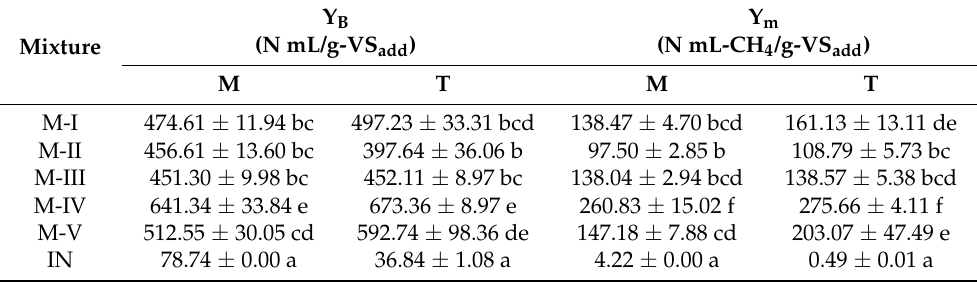
Table 3. Summary of the results of BMP assay plus One-Way ANOVA results with Tukey HSD test (values marked with the same letter in the graph are not significantly different to Tukey test, p > 0.05). Y B Y m (N mL/g-VS add ) (N mL-CH 4 /g-VS add ) Mixture M